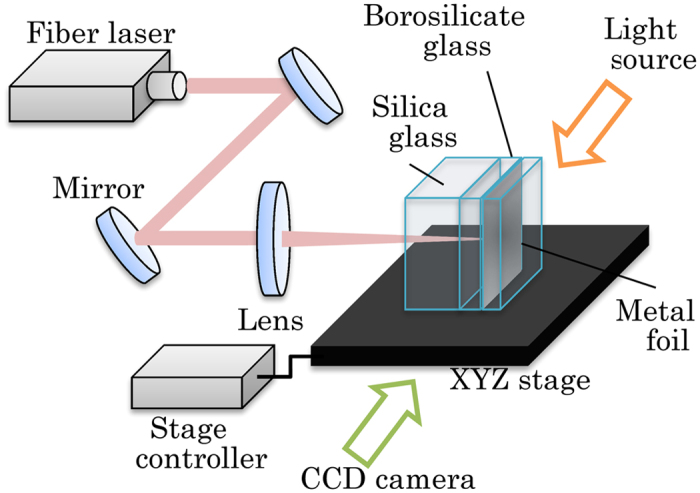
Experimental setup.